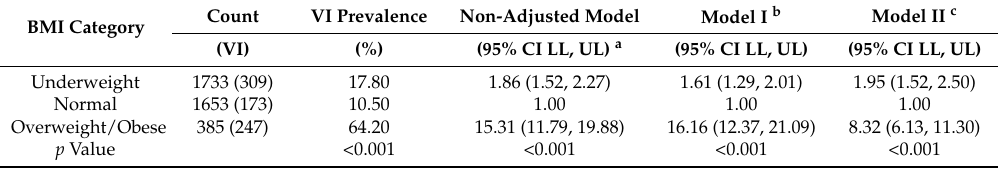
Table 2. The association between BMI and Visual Impairment (VI) in the whole population.